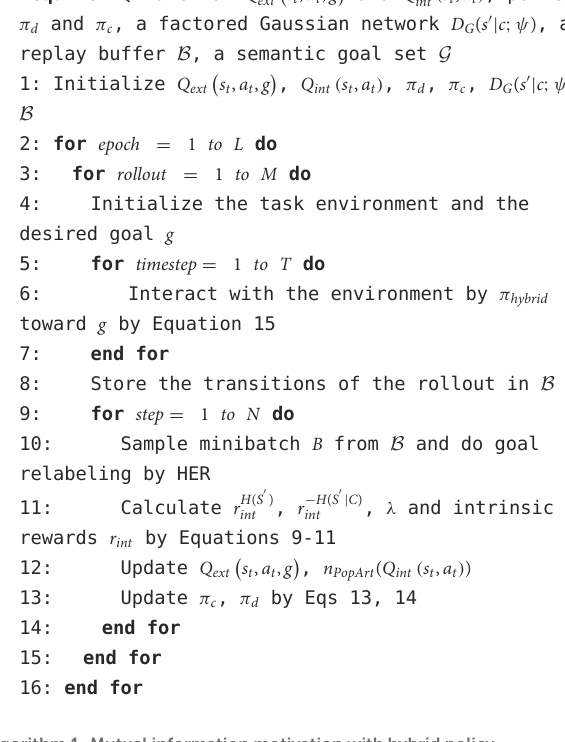
Algorithm 1. Mutual information motivation with hybrid policy mechanism